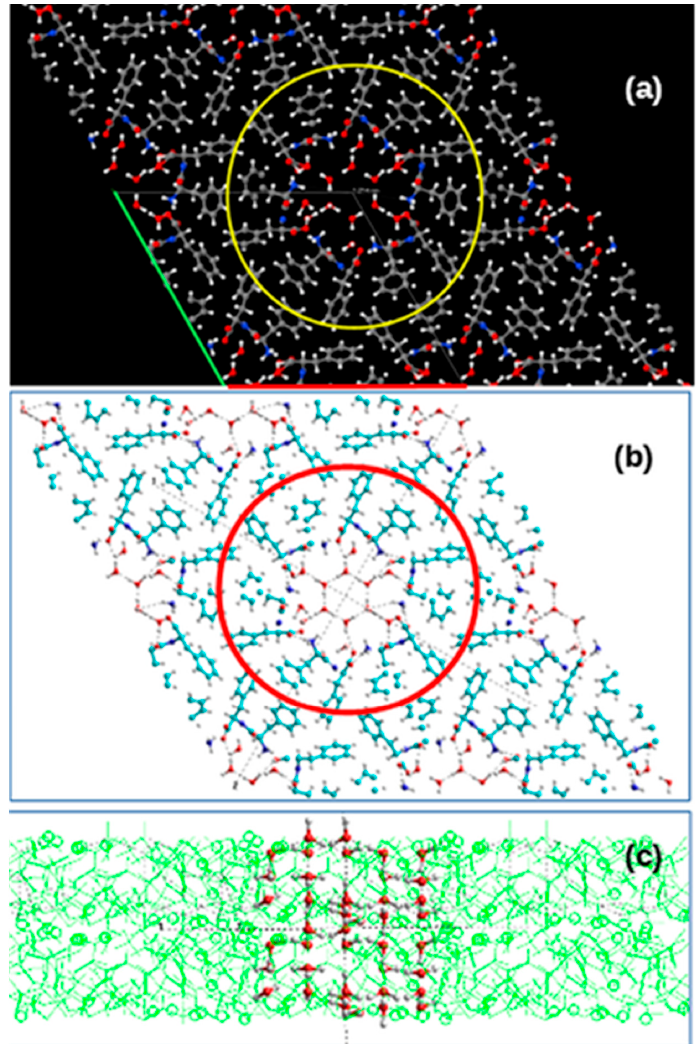
Figure 4. Schematic images of the initial water/ice cluster embedded into the inner hydrophilic cavity of the D-FF PNT: ( a ) top Z-projection images consisting from four unit cells of D-FF crystal structure obtained using Jmol from VASP initial data before optimization calculations (green and red lines marked the unit cell; yellow circle shows the selected atoms and molecules that form the PNT with cavity in the center filled with water/ice cluster molecules; the colors of atoms are the same as in Figure 1); ( b ) the same Z-projection images converted from VASP to HyperChem workspace using Cyberduck and OpenBabel software (red circle shows the same selected atoms and molecules that form the PNT with cavity in the center filled with water cluster molecules; the colours of atoms here are— Carbon is Cyan, Red is Oxygen, White (or Gray) is Hydrogen); ( c ) side Y-projection and cross-section of D-FF structures with selected water molecules formed initial water cluster. As noted above, we optimize only the structure of the water cluster inside a PNT cavity, keeping fixed (“frozen”) atomic positions of all the atoms of all the FF molecules and the unit cell parameters of the PNT crystal structures. In this case, a rearrangement of hydrogen bonds occurs both between water molecules and between water molecules and FF molecules (in particular, with nitrogen and oxygen atoms of FF molecules on the inner hydrophilic surface of the nanotube’s cavity). This happens both in D-FF PNTs and in L-FF PNTs, but in different ways in accordance with their different